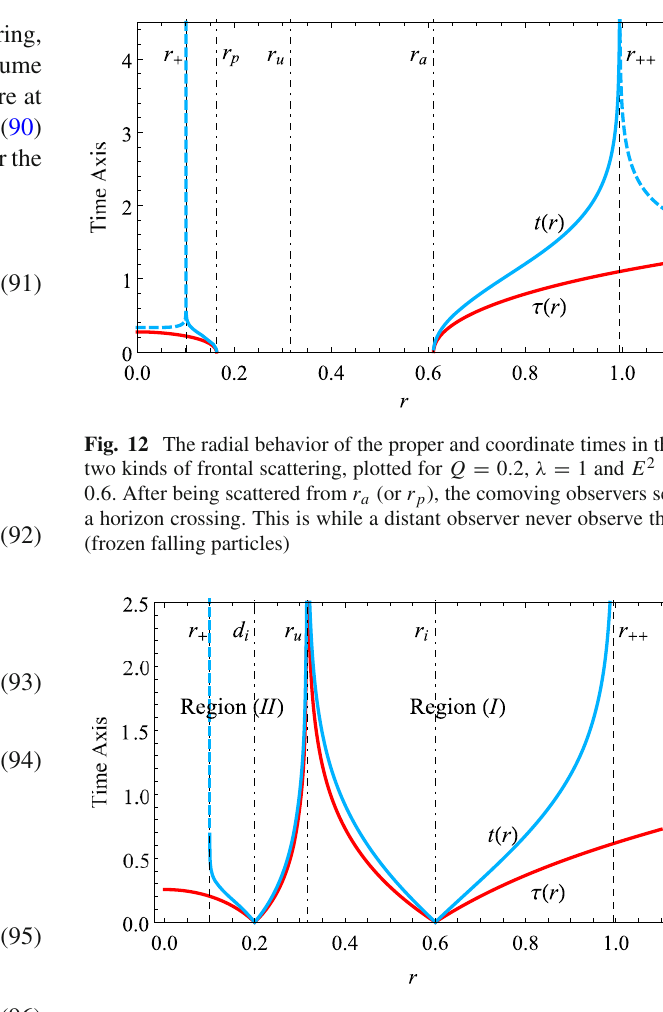
Fig. 13 Plotofthecriticalradialmotioninregions( I )and( I I ),plotted for Q = 0 . 2, λ = 1 and E 2 = 0 . 8. It is assumed r i = 0 . 6 and d i = 0 . 2. In both cases, the comoving and distant observers see that the particles approach r u asymptotically, whereas once again, the horizon crossing is seen only for comoving